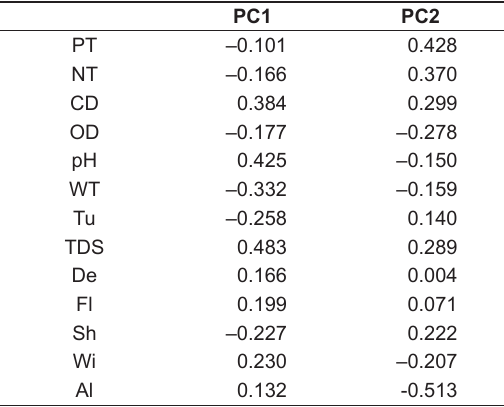
Table 1. Loading matrix of all variables on each principal component (PC). See legends in Figure 2.